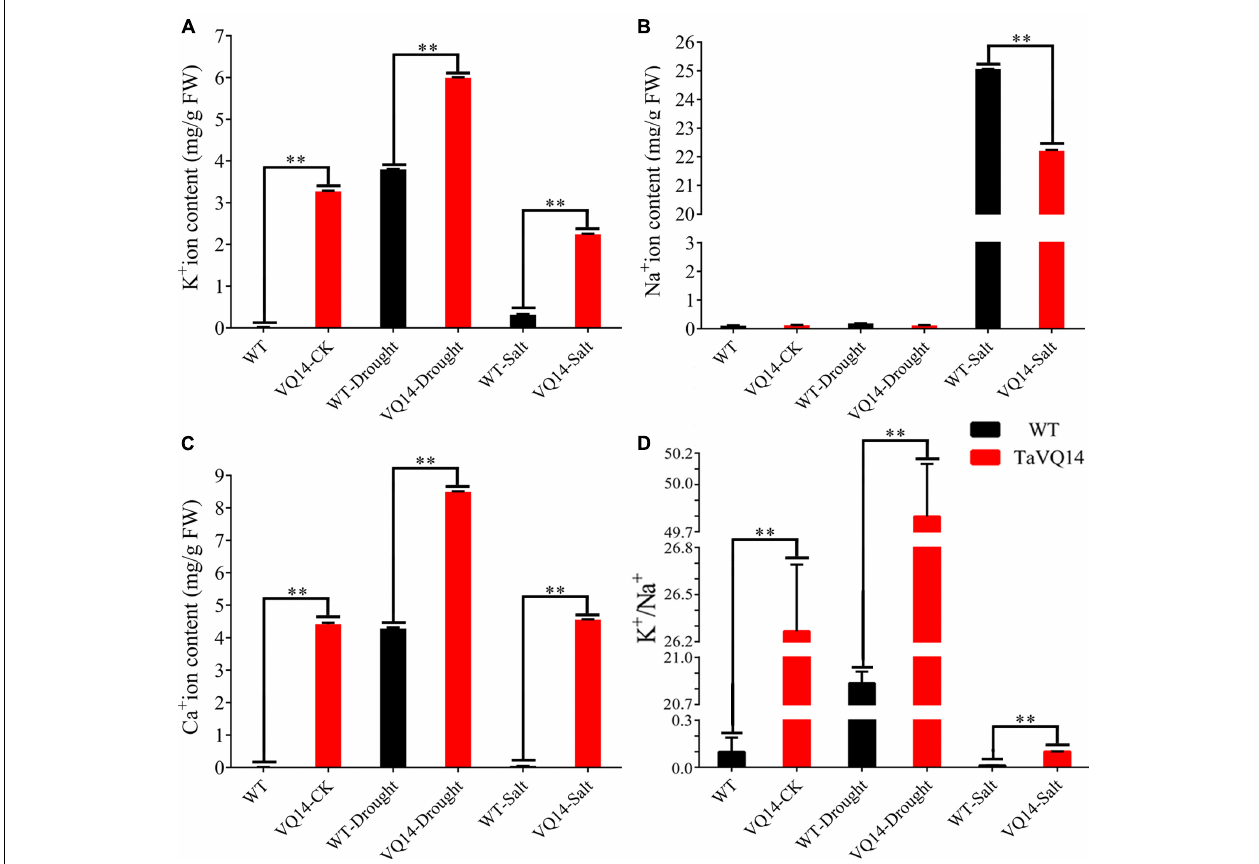
FIGURE 6 | Concentration of Na + , K + , and Ca 2 + in transgenic Arabidopsis thaliana plants under salt and drought stress. (A) K + ion content in transgenic Arabidopsis thaliana plants under salt and drought stress. (B) Na + ion content in transgenic Arabidopsis thaliana plants under salt and drought stress. (C) Ca 2 + ion content in transgenic Arabidopsis thaliana plants under salt and drought stress. (D) K + /Na + in transgenic Arabidopsis thaliana plants under salt and drought stress. ∗ P < 0.05, ∗∗ P <